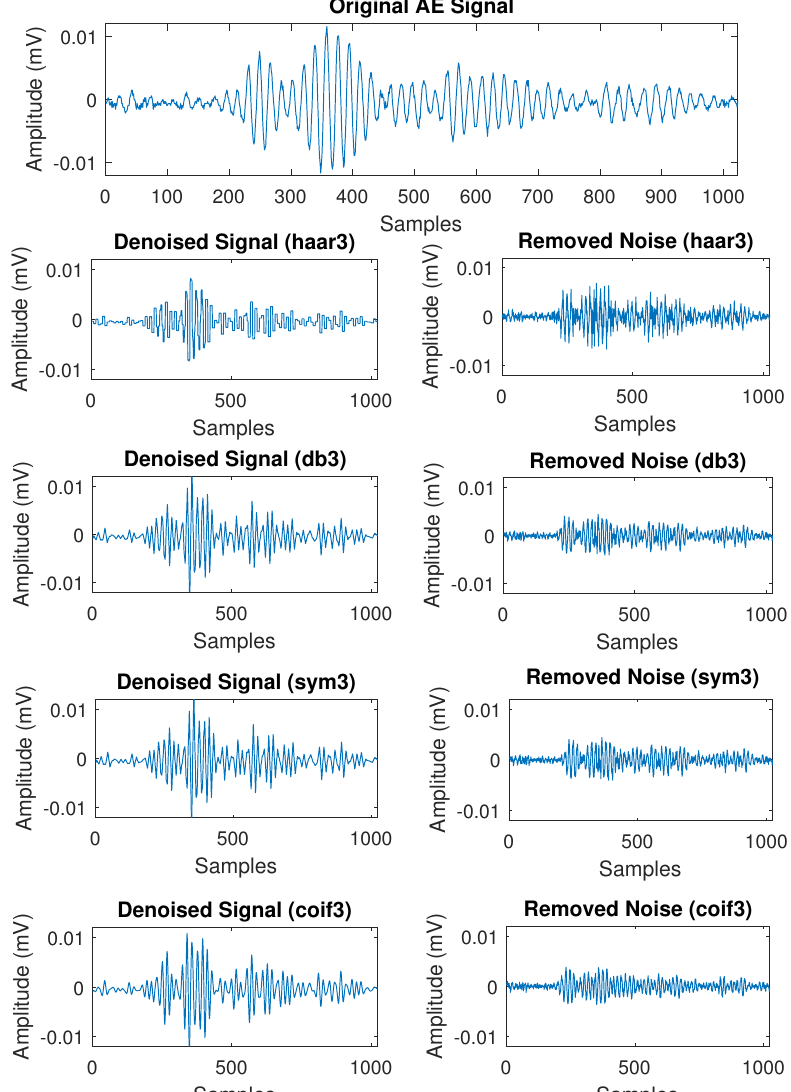
Figure 9. Noise reduction by DWT using haar3, db3, sym3 and coif3